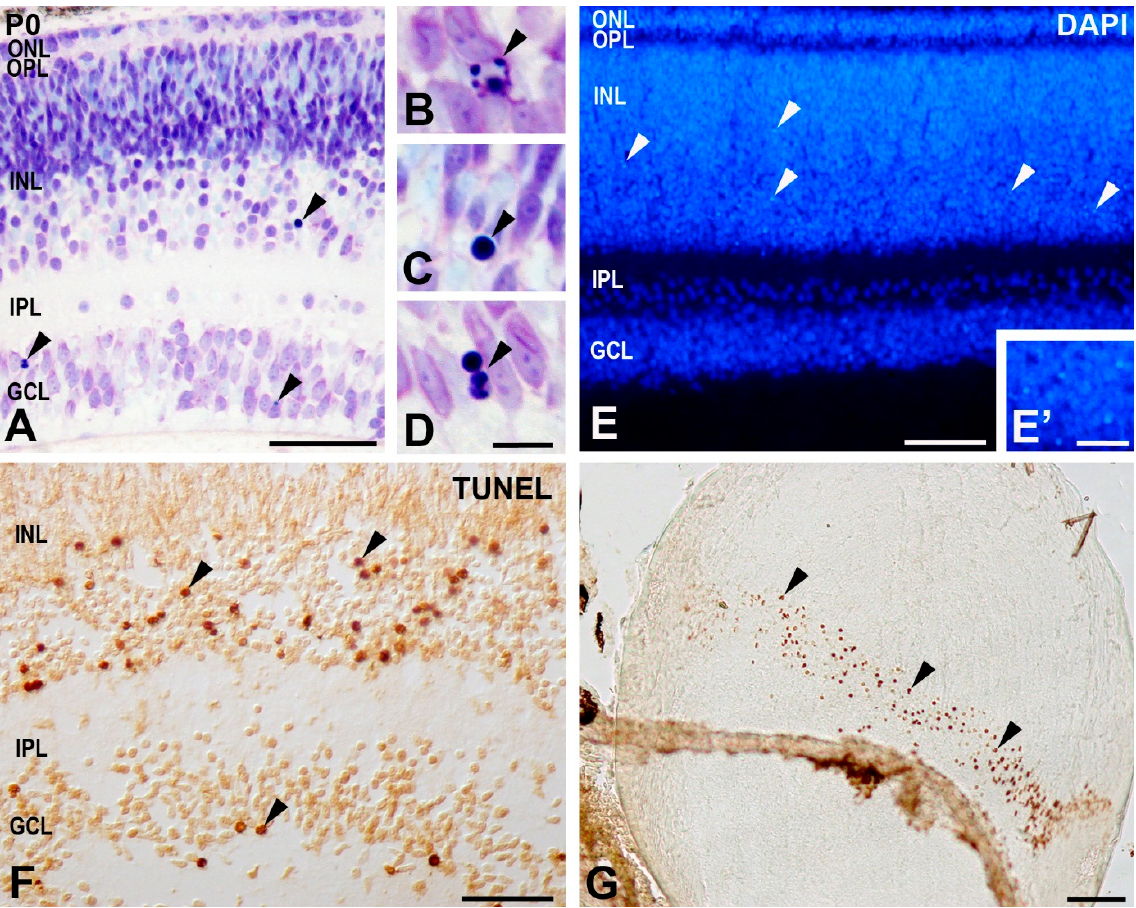
Figure 2. Programmed cell death in the T. guttata retina detected by using various sensitive methods. ( A – D ) Transversal semi-thin section of the P0 retina showing pyknotic bodies with morphological features typical of apoptosis after toluidine blue staining. ( E,E ’ ) Identification of neuronal cell death in the ganglion cell layer (GCL) and in the inner nuclear layer (INL) (arrowheads) in cryosections of T. guttata retinas at P0 stained with DAPI. ( F,G ) Eye cryosections of a P0 T. guttata hatchling showing intense abundant TUNEL-positive bodies in the GCL and INL (arrowheads in C ) and in the equatorial region of the lens (arrowheads in D ). Abbreviations: GCL, ganglion cell layer; INL, inner nuclear layer; IPL, inner plexiform layer; ONL, outer nuclear layer; OPL, outer plexiform layer. Scale bars: 50 µm (A,E–G), 7 µm (B–D,E’).